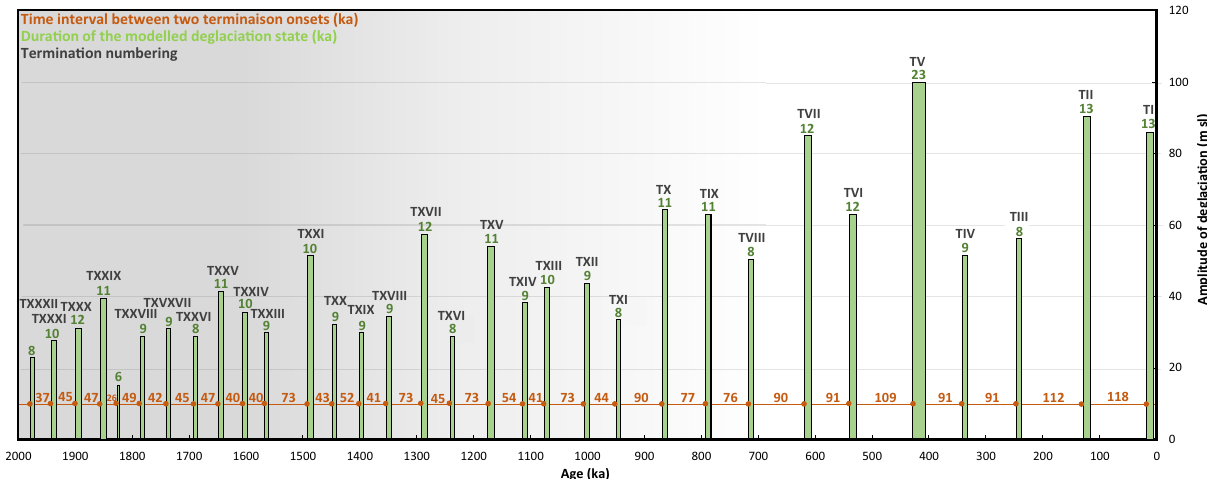
Fig. 3 Temporal structure of glacial – interglacial cycles simulated by the GRAD model. Each green stick corresponds to a deglaciation state. Height of the green stick represents the amplitude of the deglaciation in meter sea level equivalent. The width of each green stick and the associated green number indicate the duration of each of the deglaciation states. Grey roman numerals are termination names. Interval between two consecutive orange dots and the associated orange number corresponds to the time interval between two deglaciation onsets. Grey shaded area corresponds to a period of lower amplitude and higher frequency than the white